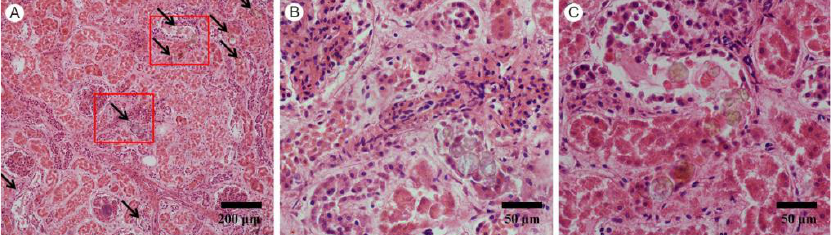
Figure 1. ( A ) Multiple distributions of crystals in renal parenchyma of the patient (HE, magnification 100×); ( B ) a crystal cluster in the renal tubule (HE, magnification 400×); ( C ) crystals were lining up in the renal tubule (HE, magnification 400×).